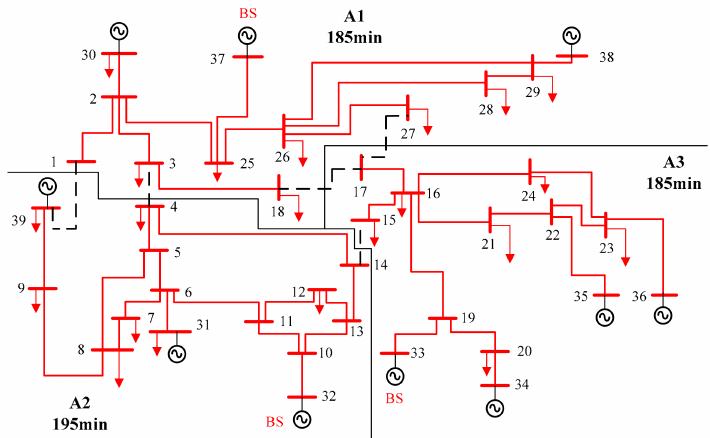
Figure 6. Initial solution for A1, A2 and A3 islands with 5 cutting